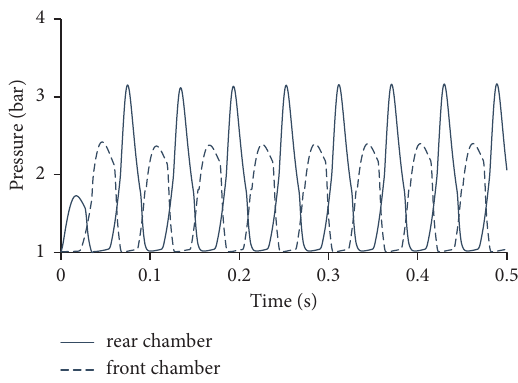
Figure 7: Pressure curves in the rear and front chambers.